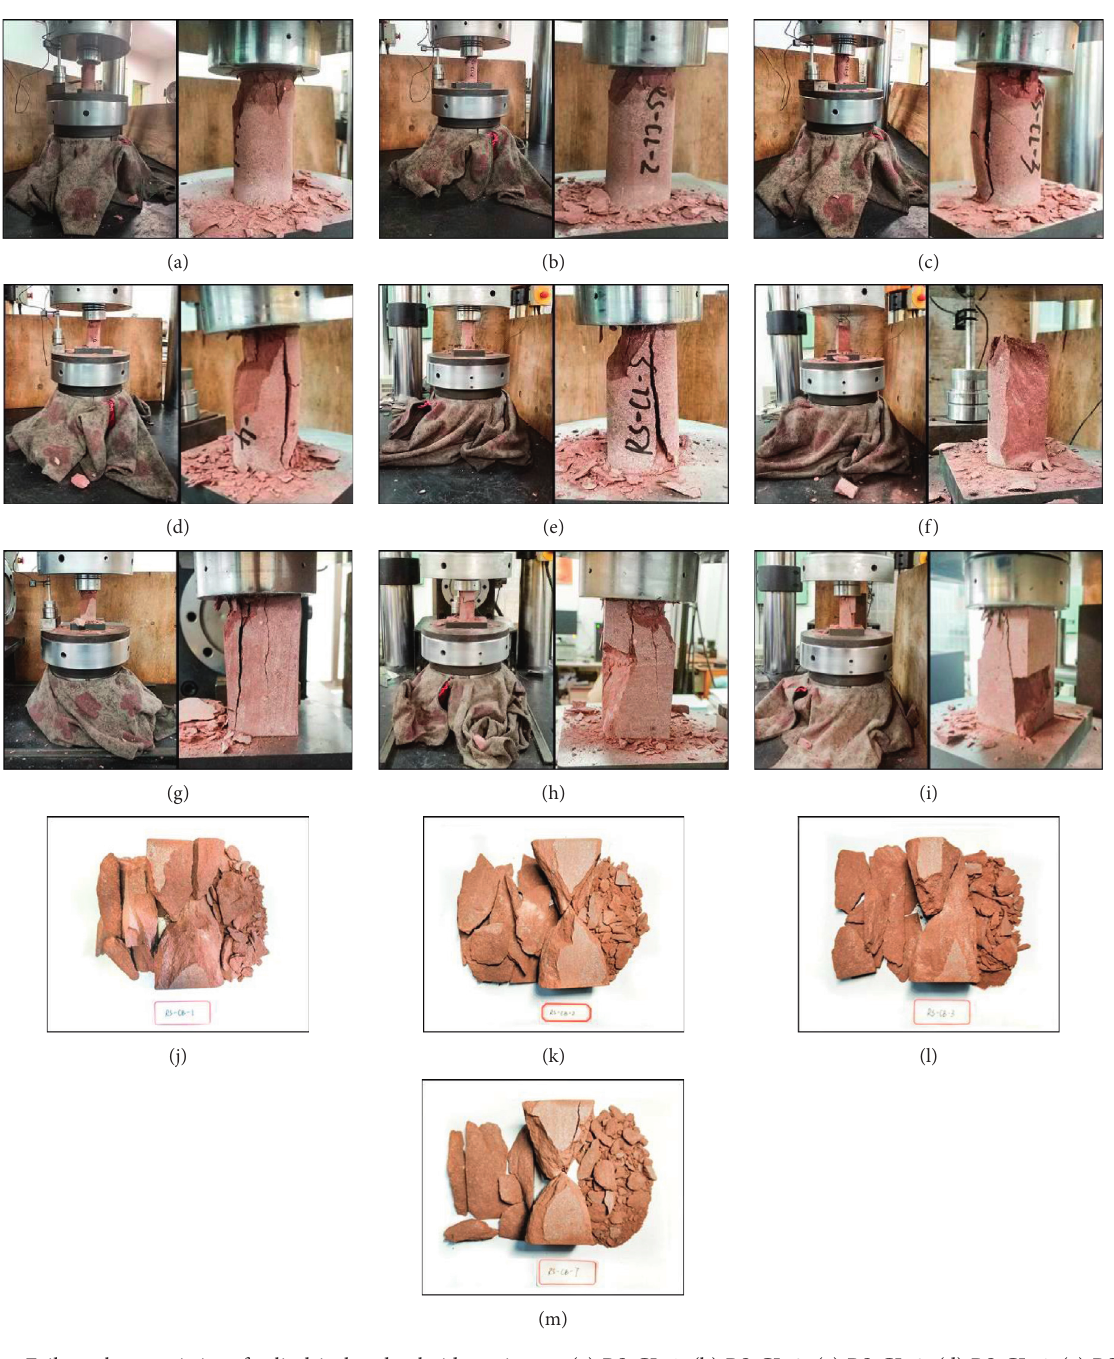
Figure 7: Failure characteristics of cylindrical and cuboid specimens. (a) RS-CL-1. (b) RS-CL-2. (c) RS-CL-3. (d) RS-CL-4. (e) RS-CL-5. (f) RS-CL-6. (g) RS-CB-4. (h) RS-CB-5. (i) RS-CB-6. (j) RS-CB-1. (k) RS-CB-2. (l) RS-CB-3. (m)